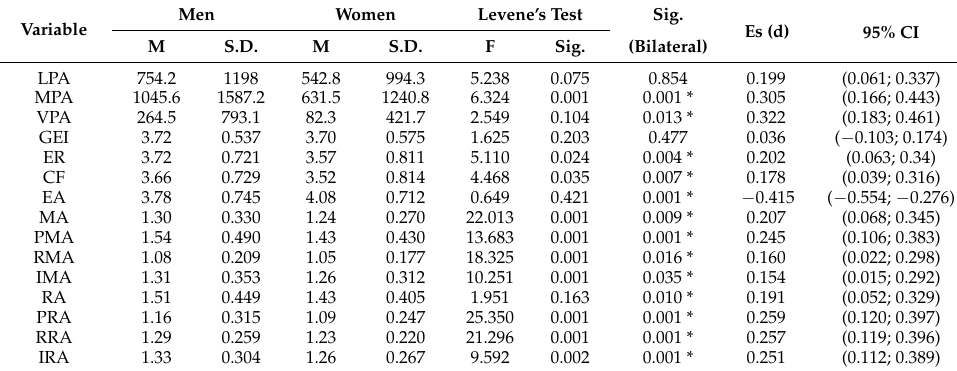
Table 1. EI, aggressive behaviours and PA practice according to participants’ sex.